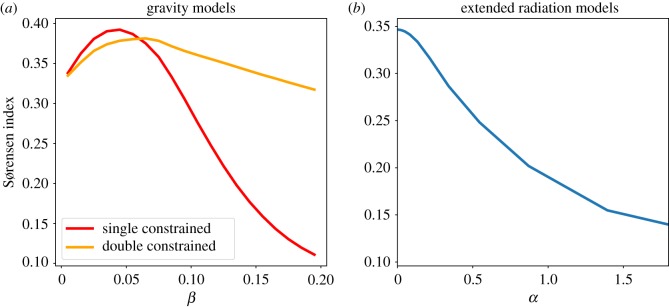
We show the behaviour of the Sørensen's index for (a) the gravity models and (b) the extended radiation model. If the gravity models exhibit a clear maximum for βsingle = 0.045, βdouble = 0.065, in the extended radiation context this is reached asymptotically for α→0.